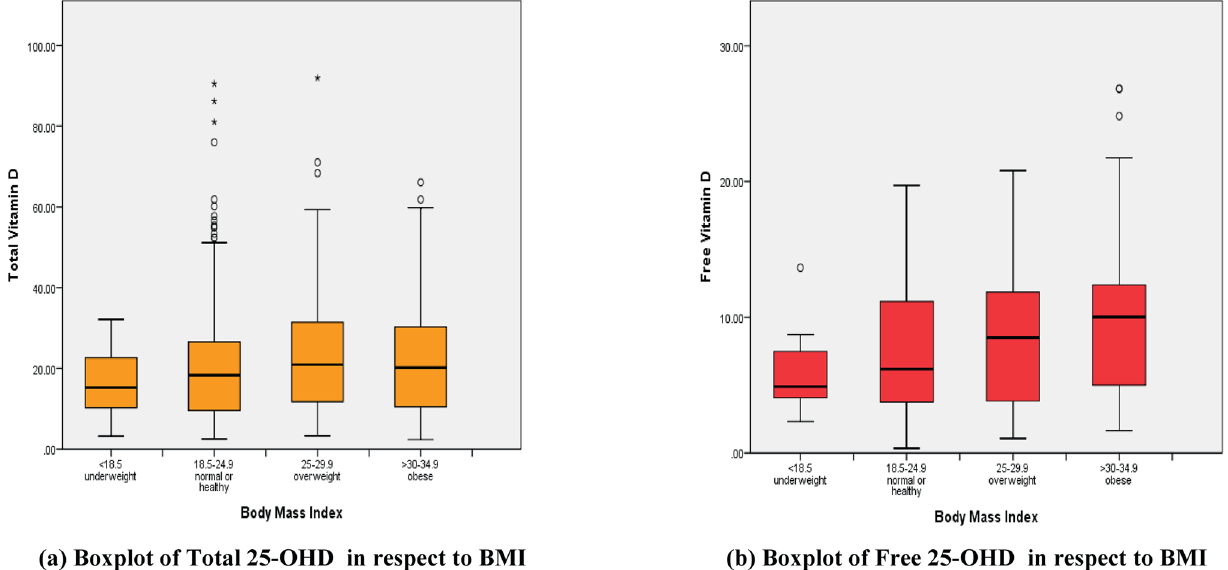
Figure 2. ( a ) Boxplot of Total 25-OHD in respect to BMI, ( b ) Boxplot of Free 25-OHD in respect to